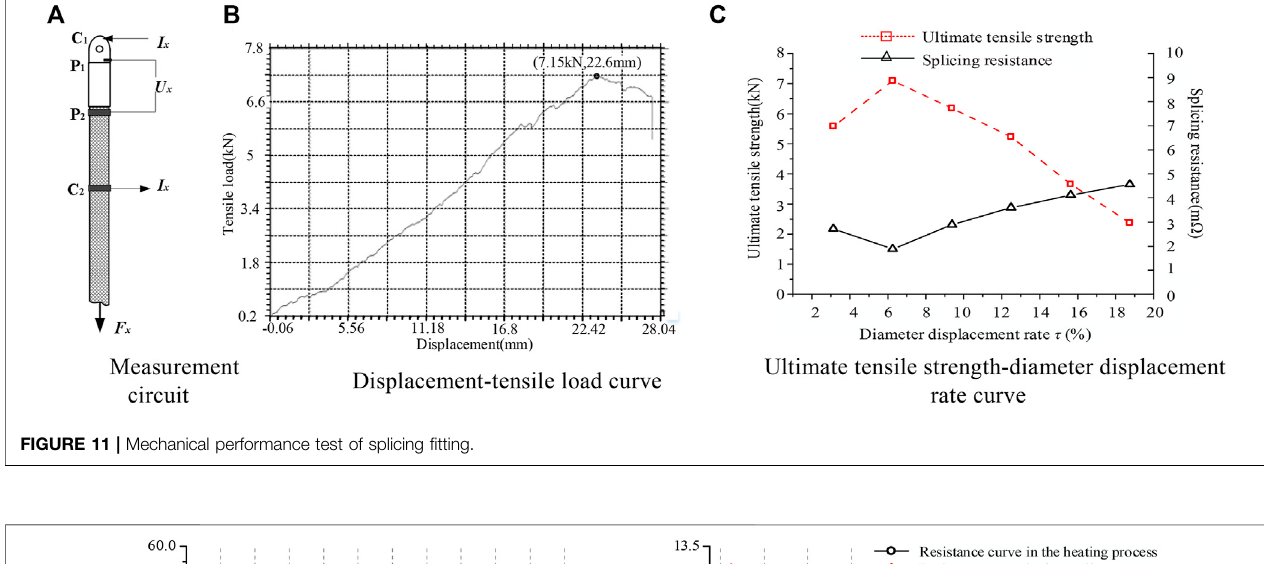
FIGURE 11 | Mechanical performance test of splicing fi tting.